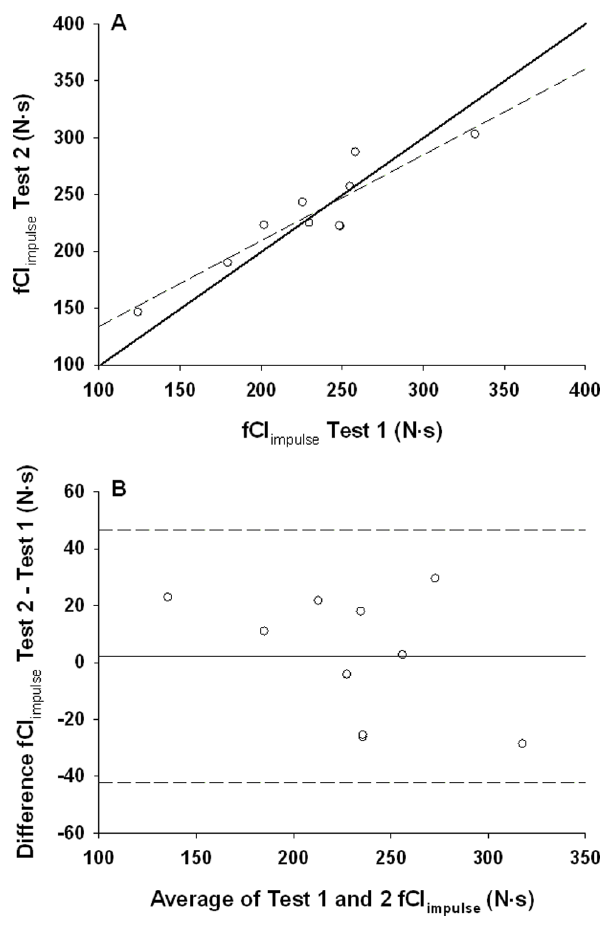
Figure 5. Test-retest correlations of fCF impulse . Panel A: fCF as force impulse. Line of identity is shown as a solid line and the fitted regression as a dashed line. Panel B: Bland-Altman plot of fCF impulse . Mean difference between test 1 and test 2 (bias; solid line). 6 44.5 N ? s 95% limits of agreement (dashed lines).